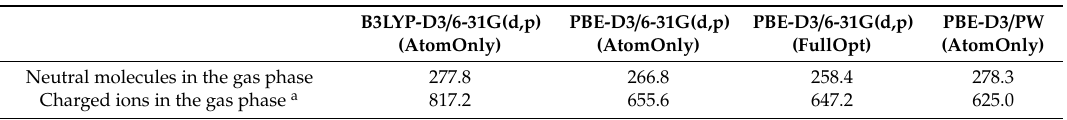
B3LYP-D3 / 6-31G(d,p) PBE-D3 / 6-31G(d,p) PBE-D3 / 6-31G(d,p) PBE-D3 / PW (AtomOnly) (AtomOnly) (FullOpt) (AtomOnly)